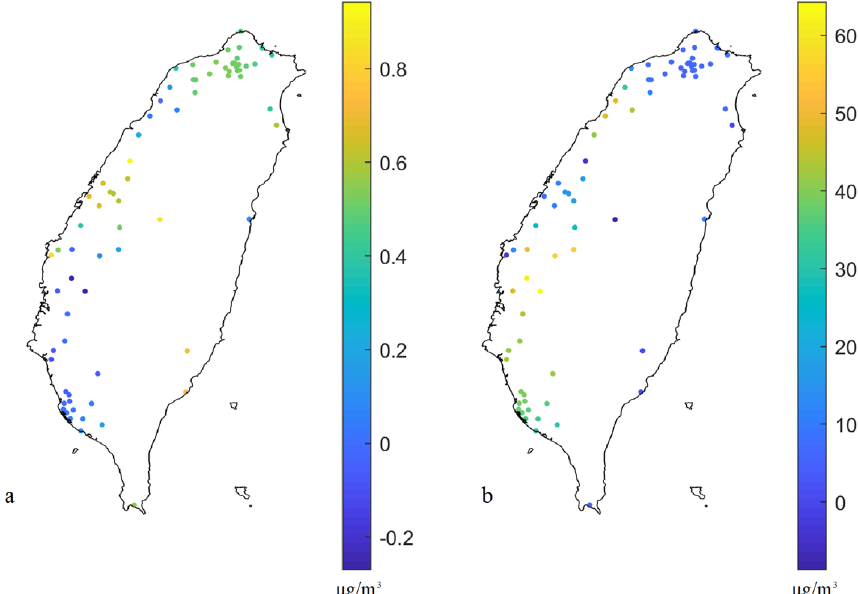
Figure 6. Coefficients of the spatial calibration model: ( a ) slope and ( b ) intercept based on the spatial calibration model (Eq. 4). The plots were created in MATLAB_R2018B (https ://www.mathw orks.com/produ cts/ matla